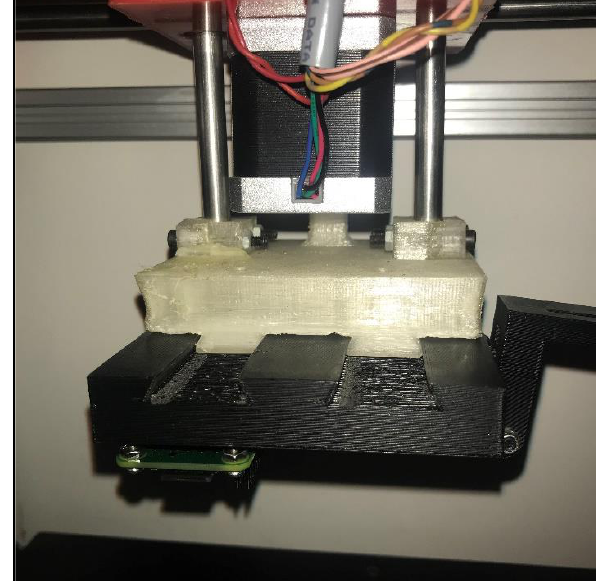
Figure 2 . The head of the system can be easily adapted thanks to the dovetails